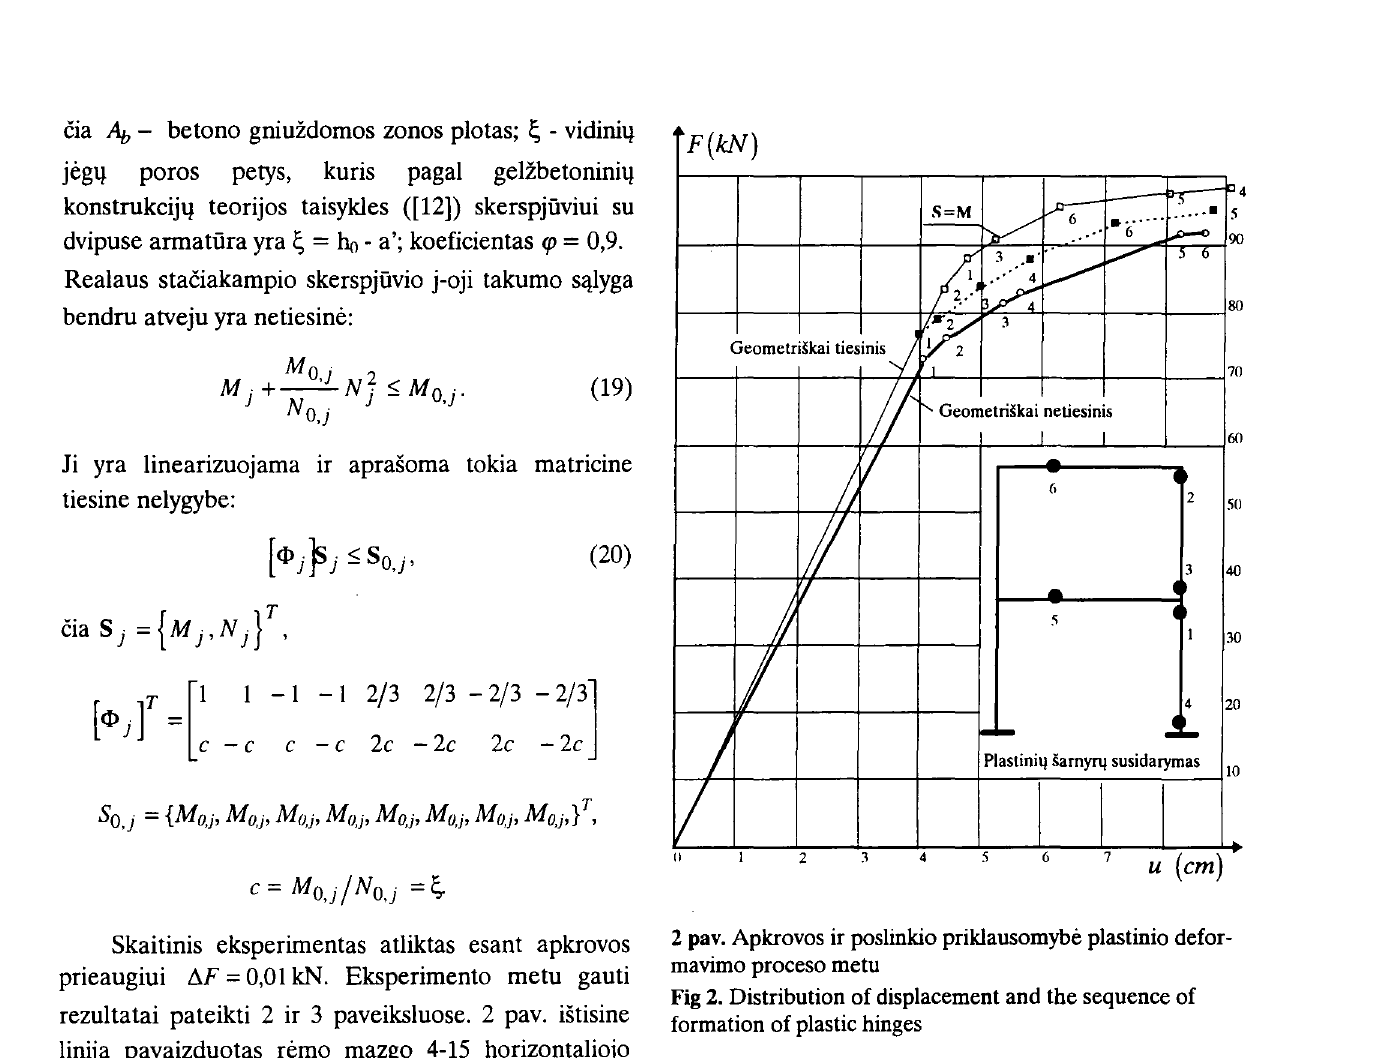
Fig 2. Distribution of displacement and the sequence of formation of plastic hinges